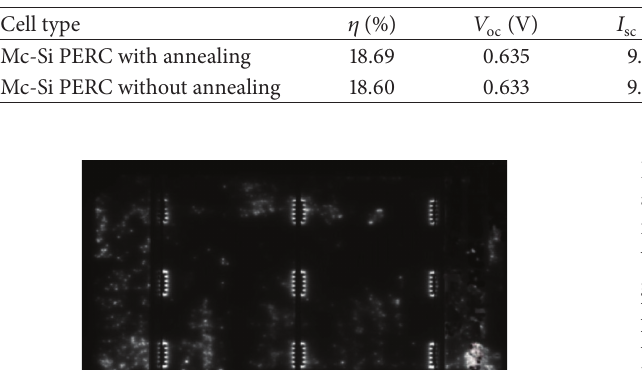
Table 6: Efficiency improvement of Mc-Si PERC after annealing.